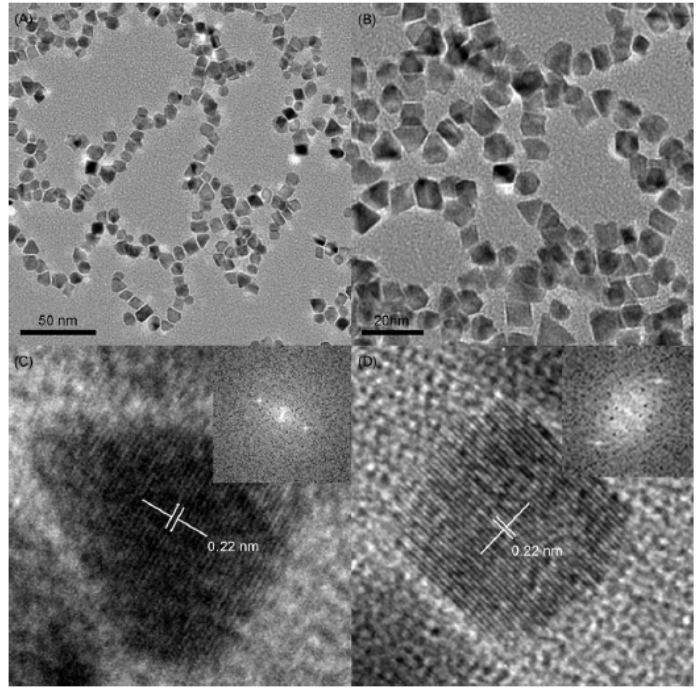
Figure 3. TEM images of triangular and rectangular shaped palladium nanoparticles Reprinted from [41] with permission from Wiley-VCH Verlag GmbH and Co., ©